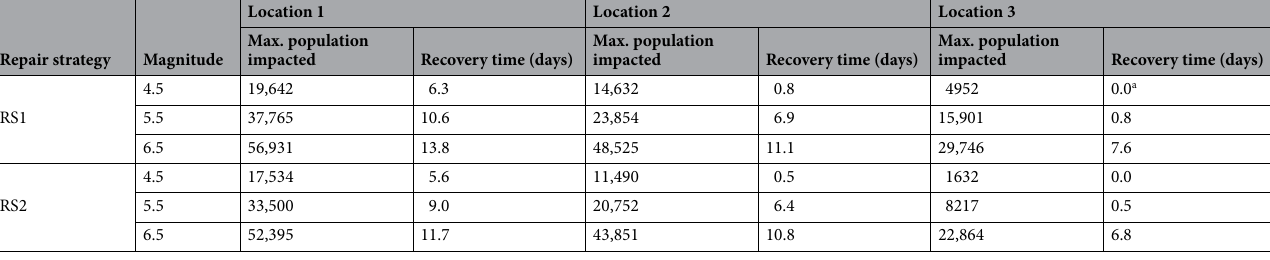
Table 6. Maximum population impacted and recovery time for studied earthquake scenarios. Values are computed using the median of the 50 realizations for each scenario. a A recovery time of 0 implies that the median value for population impacted never dropped below 10% of total